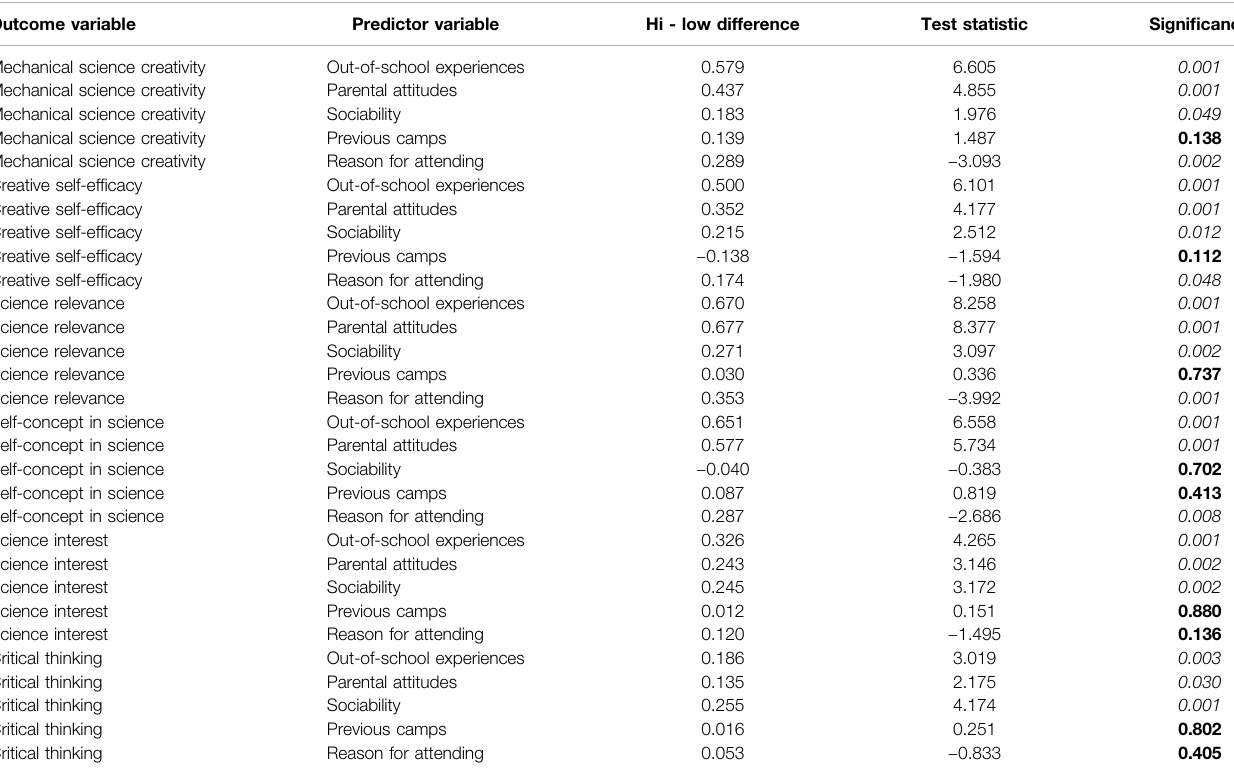
TABLE 5 | Past participant difference in predicted outcome variable scores based on high/low predictor variable group. Outcome variable Predictor variable